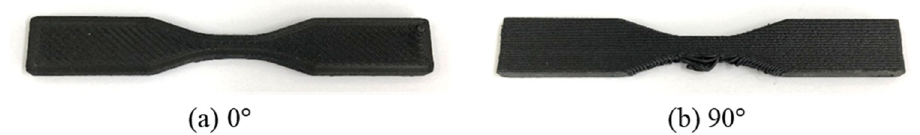
Figure 8. Interaction effect plots of the significant factors for the dimensional accuracy of ASTM D638.